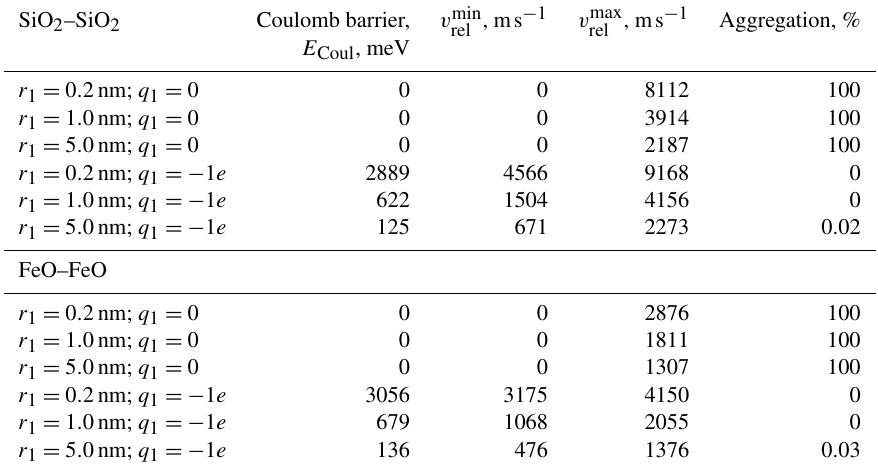
Table 3. Energetic considerations and the percentage of aggregation for SiO 2 –SiO 2 and FeO–FeO collisions at T = 150K and k r = 0 . 9 (the surface point charge model). Particle 2 has a fixed radius and charge ( r 2 = 0 . 2nm; q 2 = − 1 e ), and the size and charge of particle 1 is varied. The collision geometry is shown in Fig.